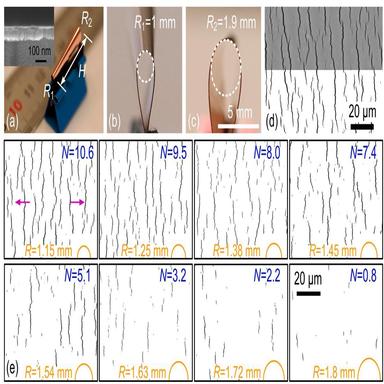
Representative results showing sample bent asymmetrically and cracks for different bending radii. a) Photograph of a bent sample. Only a very common foldback clip is used to fix the two unparallel edges. The inset shows the SEM image of the cross section. b) and c) Photographs showing R1=1 mm and R2=1.9 mm by fitting the curved cross section with a circle, respectively. d) Comparison of as-captured (upper panel) and post-processed SEM image (lower panel) of cracked surface. e) Evolution of cracks as local R